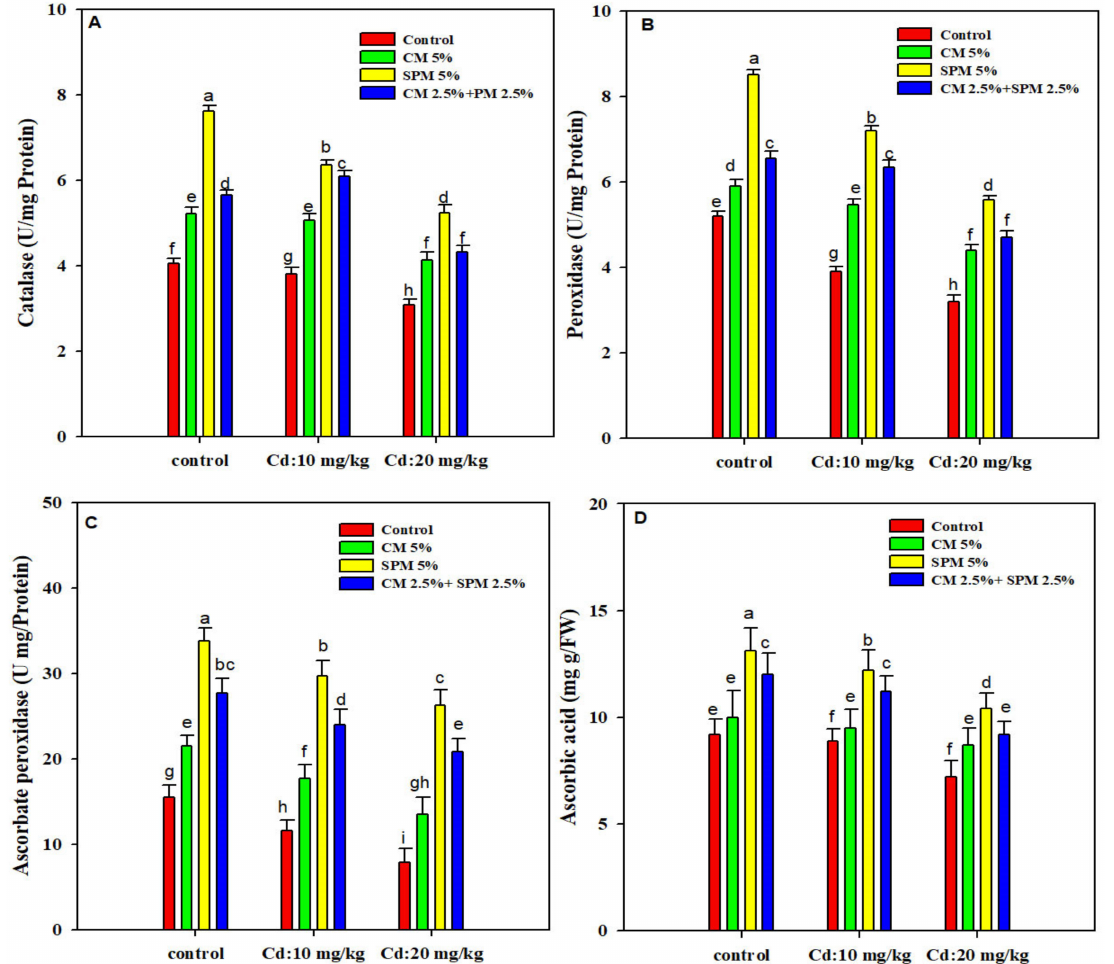
Figure 4. Effect of organic amendments on CAT ( A ), POD ( B ), APX ( C ) and AsA ( D ) activities of mash bean plants subjected to different levels of Cd stress (0, 10 and 20 mg/kg). The vertical bars in each figure are the mean of three replications with ± S.E. and different letters on bars indicating the significant difference at p <